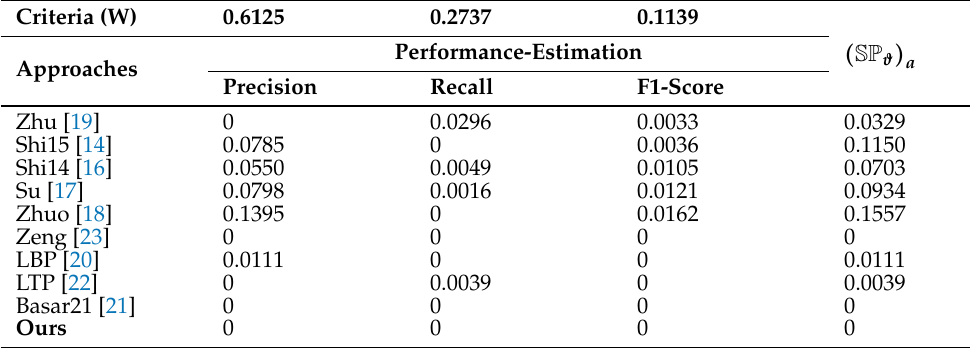
Table 8. Analysis outputs of the calculated aggregate ( P ϑ ) .